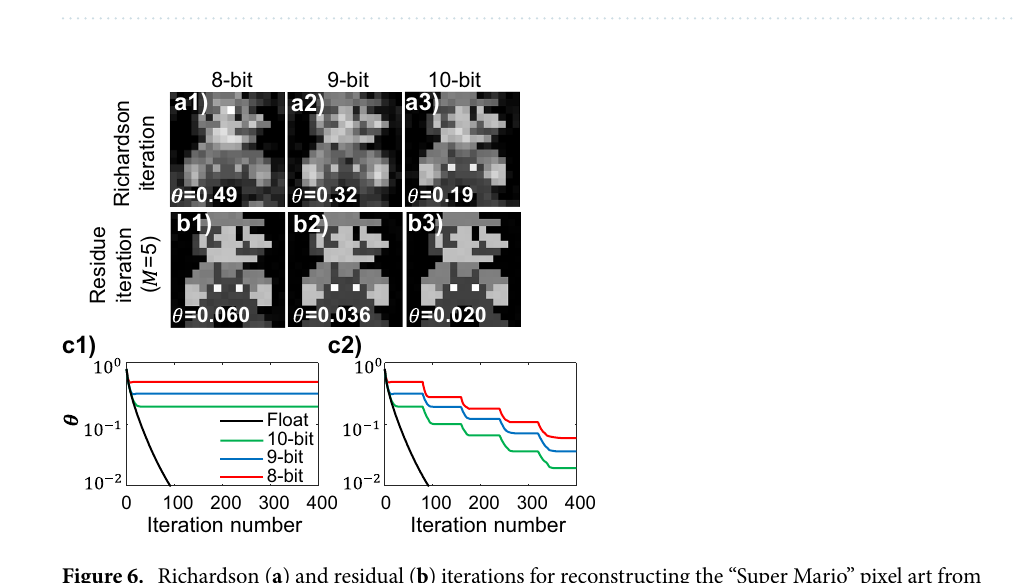
Figure 6. Richardson ( a ) and residual ( b ) iterations for reconstructing the “Super Mario” pixel art from tomographic measurements. ( a ) Reconstructions from 8-bit (a1), 9-bit (a2), and 10-bit (a3) Richardson iterations. ( b ) Reconstructions from 8-bit (b1), 9-bit (b2), and 10-bit (b3) residual iterations after M =5 residue